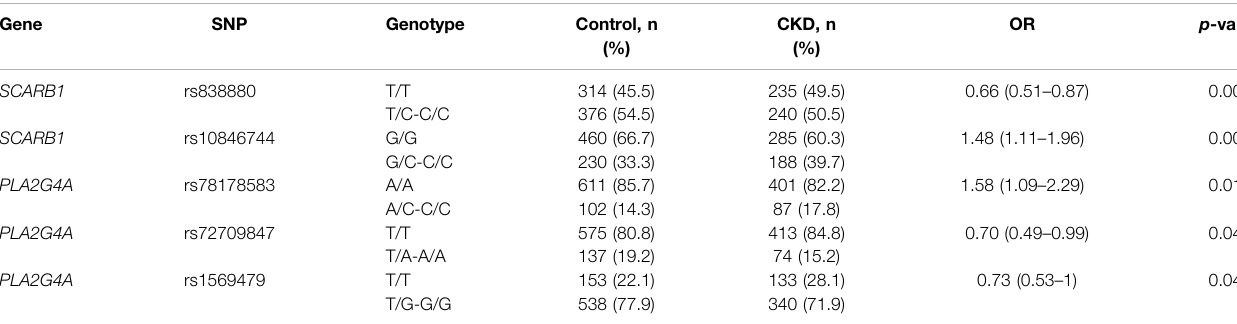
TABLE 2 | Adjusted risk analysis for the risk of